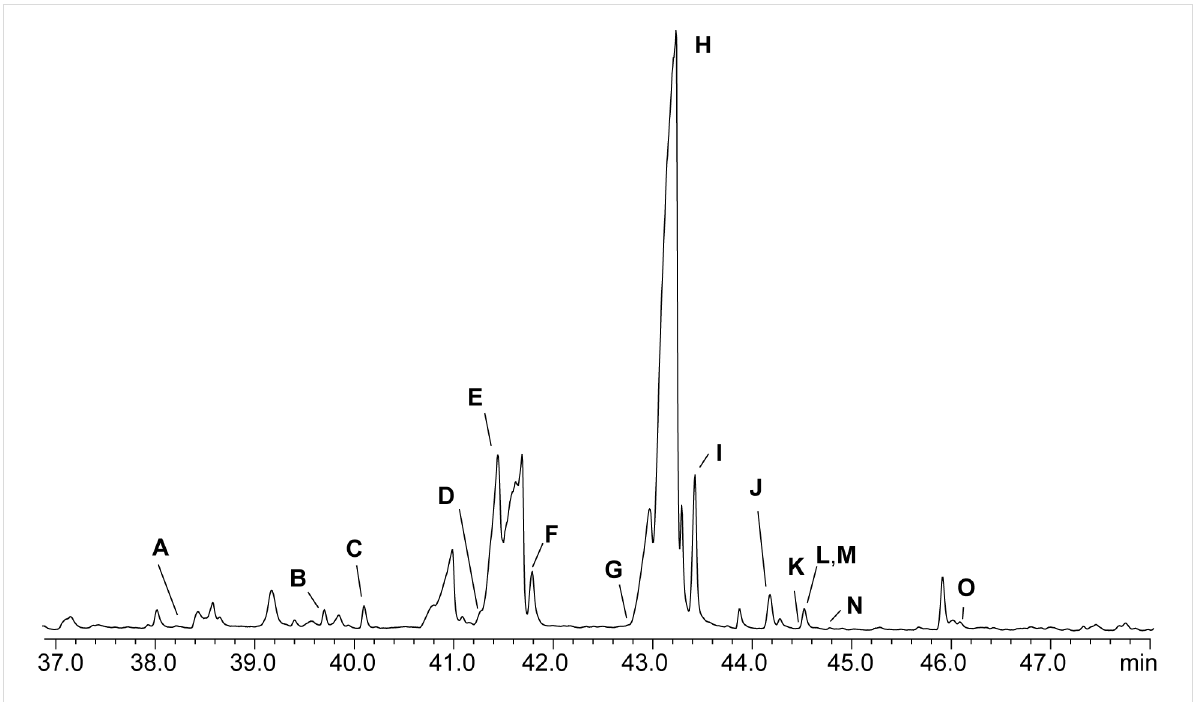
Figure 2: Total ion chromatogram (TIC) of an XAD extract of Roseovarius sp. D12_1.68. AHLs, NAMEs and related compounds are assigned by bold letters (Table 1).